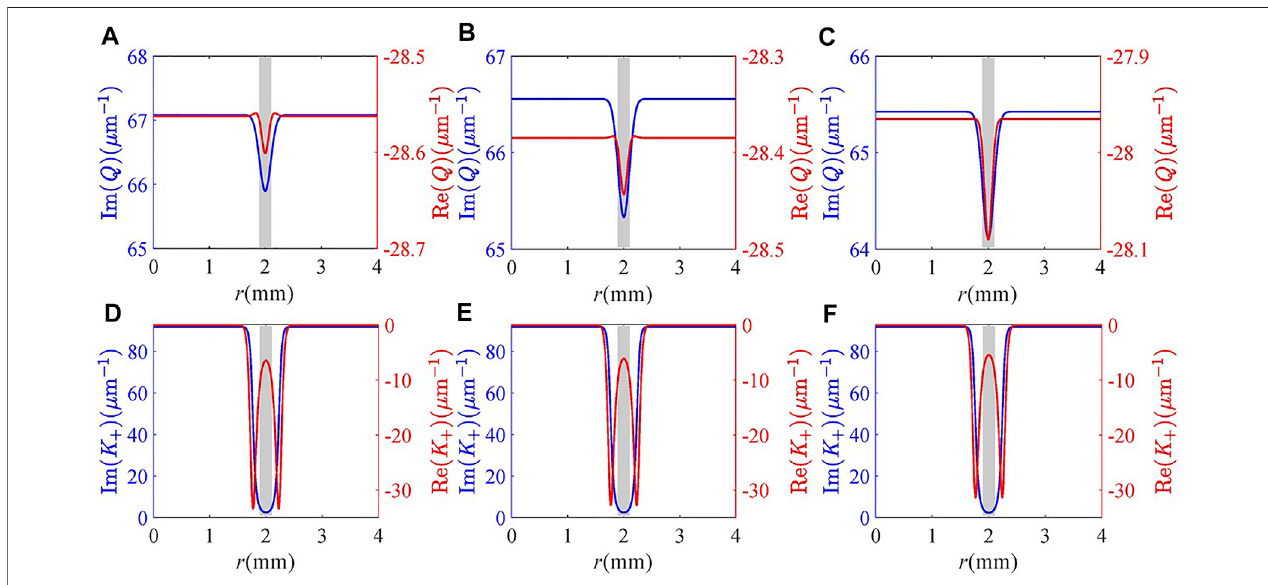
FIGURE 7 | Real and imaginary parts of (A – C) Q and (D – F) K + versus radius r for different coupling detuning Δ c : (A,D) Δ c = 4 meV; (B,E) Δ c = 8 meV; (C,F) Δ c = 16 meV. Other parameters are the same as in Figure 4C .